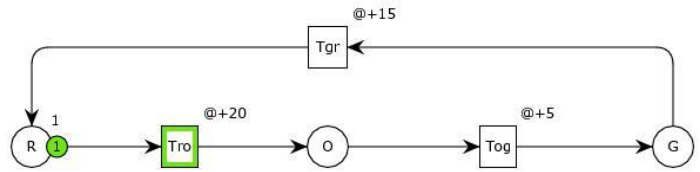
Figure 2. CPN Model of a Traffic Light System with Temporal Behavior.